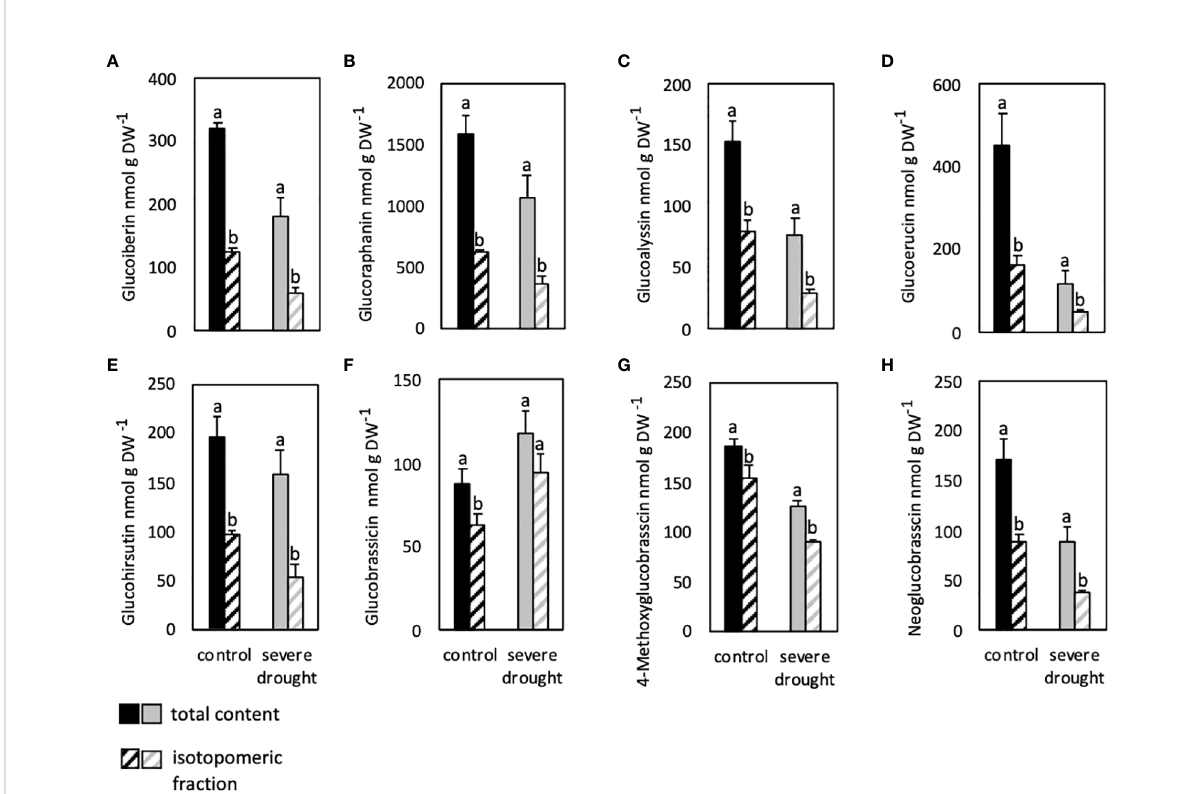
FIGURE 3 Isotopomeric and total contents of aliphatic (A – E) and indolic glucosinolates (F – H) in leaves of severely drought-stressed Arabidopsis thaliana Col-0 plants subjected to 40% PEG 20,000 and 30% D 2 O for seven days. Plants were grown on petri dishes for fi ve weeks prior to application of severe drought stress (40% PEG 20,000). Bars represent means of three biological replicates consisting of four pooled plants each. Different letters indicate signi fi cant differences (p<0.05) between total glucosinolate contents and isotopomeric